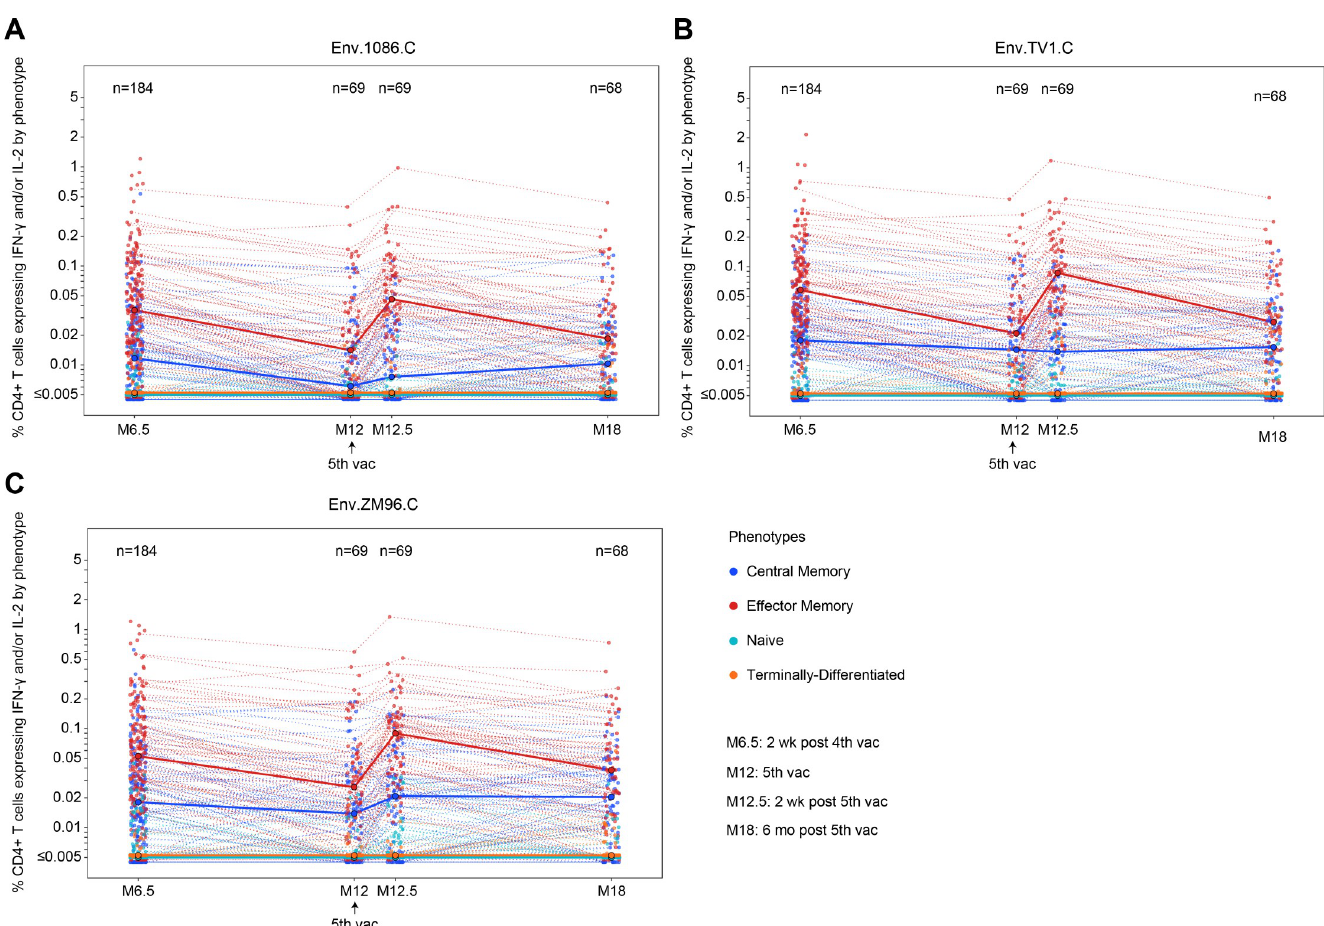
Fig 7. Memory sub-populations of 1086.C gp120, TV1.C gp120, and ZM96.C antigen-specific CD4+ T cells amongst vaccine recipients in HVTN 100. Memory sub-populations of 1086.C (A), TV1.C (B), and ZM96.C (C) antigen-specific CD4+ T cells. Frequencies of central memory (dark blue symbols, CD45RA − CCR7 + ), effector memory (red symbols, CD45RA − CCR7 − ), na ï ve (teal symbols, CD45RA + CCR7 + ), and terminally differentiated (orange symbols, CD45RA + CCR7 − ) CD4+ T cells expressing IFN- γ or IL-2 out of total CD4+ T cells are shown 2 weeks after the fourth vaccination (month 6.5), 6 months after the fourth vaccination (month 12), 2 weeks after the fifth vaccination (month 12.5), and 6 months after the fifth vaccination (month 18). Black circles represent median antigen-specific sub-populations at each timepoint. Dashed lines connect the frequencies of each memory sub-population for each per-protocol vaccine recipient over time. M[number], month [number]; vac, vaccination.